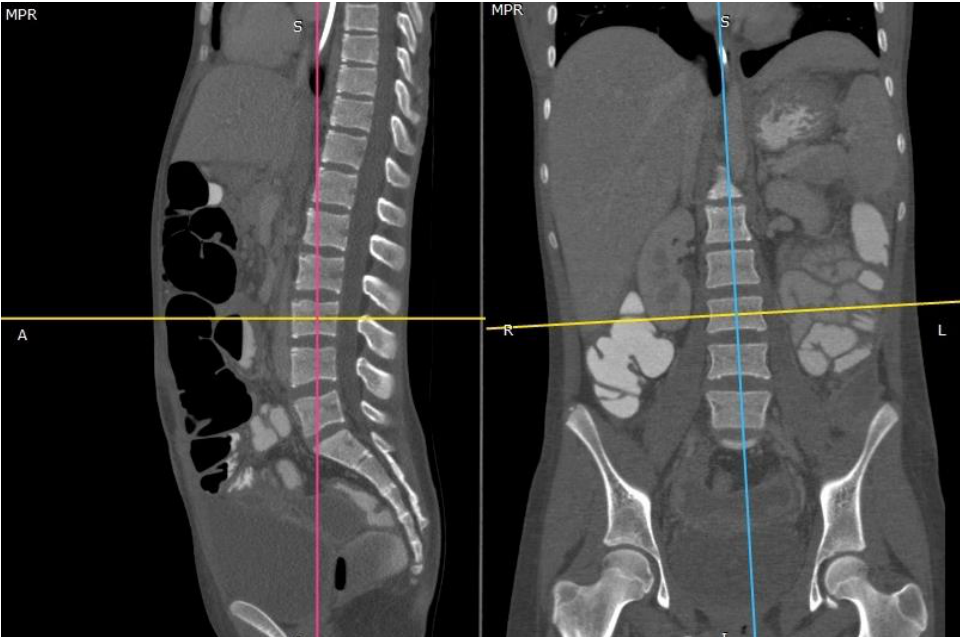
Figure 2. Mid-sagittal and mid-coronal reconstructions were used for each spinal level to describe the presence of ossification and fusion in four areas of each ring.